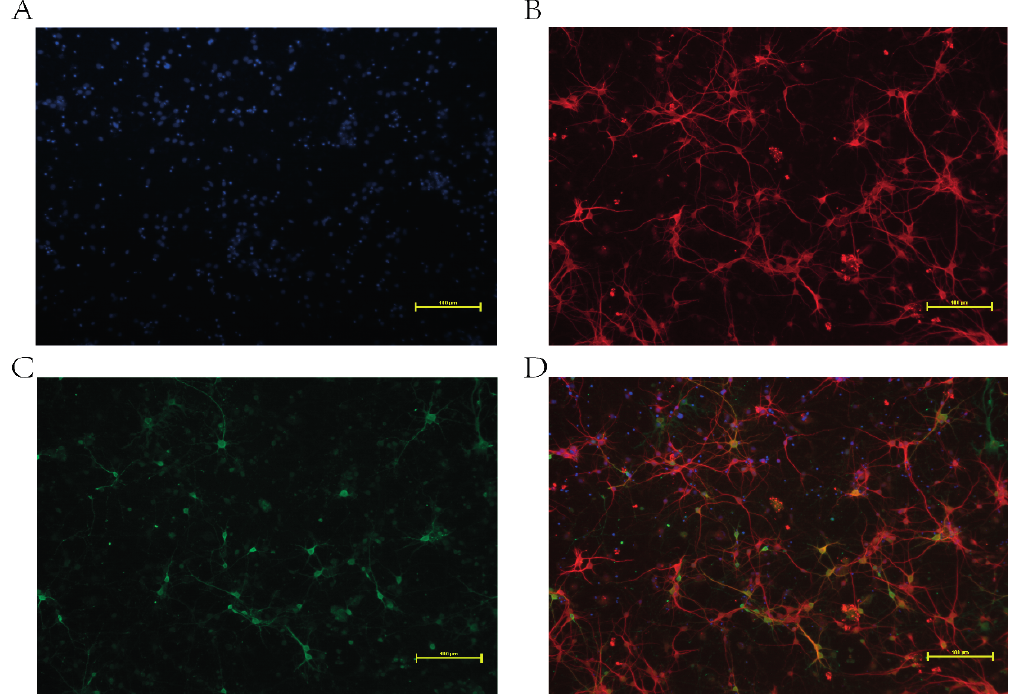
Figure 1. Immunofluorescence analysis of Borna disease virus (BDV)-infected neurons on day 12 post-infection. ( A ) Nuclei stained with DAPI (4 ′ ,6-diamidino-2-phenylindole) (blue); ( B ) Neurons marked with chicken polyclonal MAP-2 (neuron-specific marker) followed by a FITC (Fluorescein isothiocyanate isomer I)-labeled secondary antibody (red, goat anti-chicken); ( C ) BDV P40 detected with a primary monoclonal antibody followed by a FITC-labeled secondary antibody (green, goat anti-mouse); ( D ) Merged image. Scale bars: 100 μ